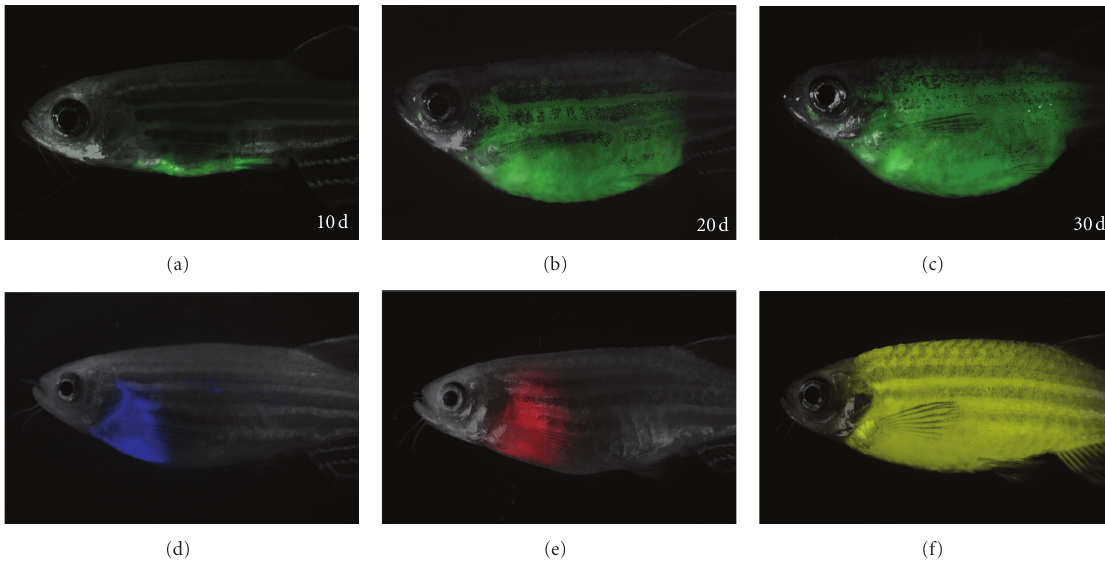
Figure 1: Fluorescently labeled Myc-induced T-ALLs from CG1-strain zebrafish engraft into nonirradiated CG1-strain recipients. (a)–(c) GFP-labeled T-ALLs were isolated from primary leukemic fish, and 1 × 10 3 FACS sorted GFP-labeled leukemia cells were transplanted into nonirradiated CG1-strain animals and scored for engraftment at 10, 20, and 30 days posttransplantation. (d)–(f) T-ALL transplant recipients that express Amcyan (d), dsRED (e), and zsYellow (f) under the rag2 promoter. Panels are merged images of fluorescent and brightfield photographs. Images were originally published in